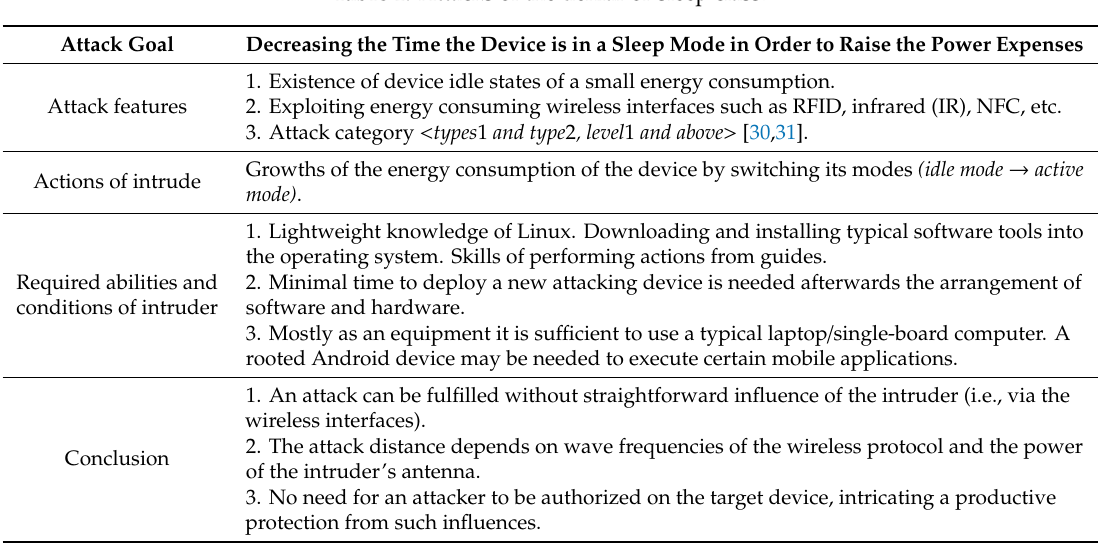
Table 1. Attacks of the denial-of-sleep class.